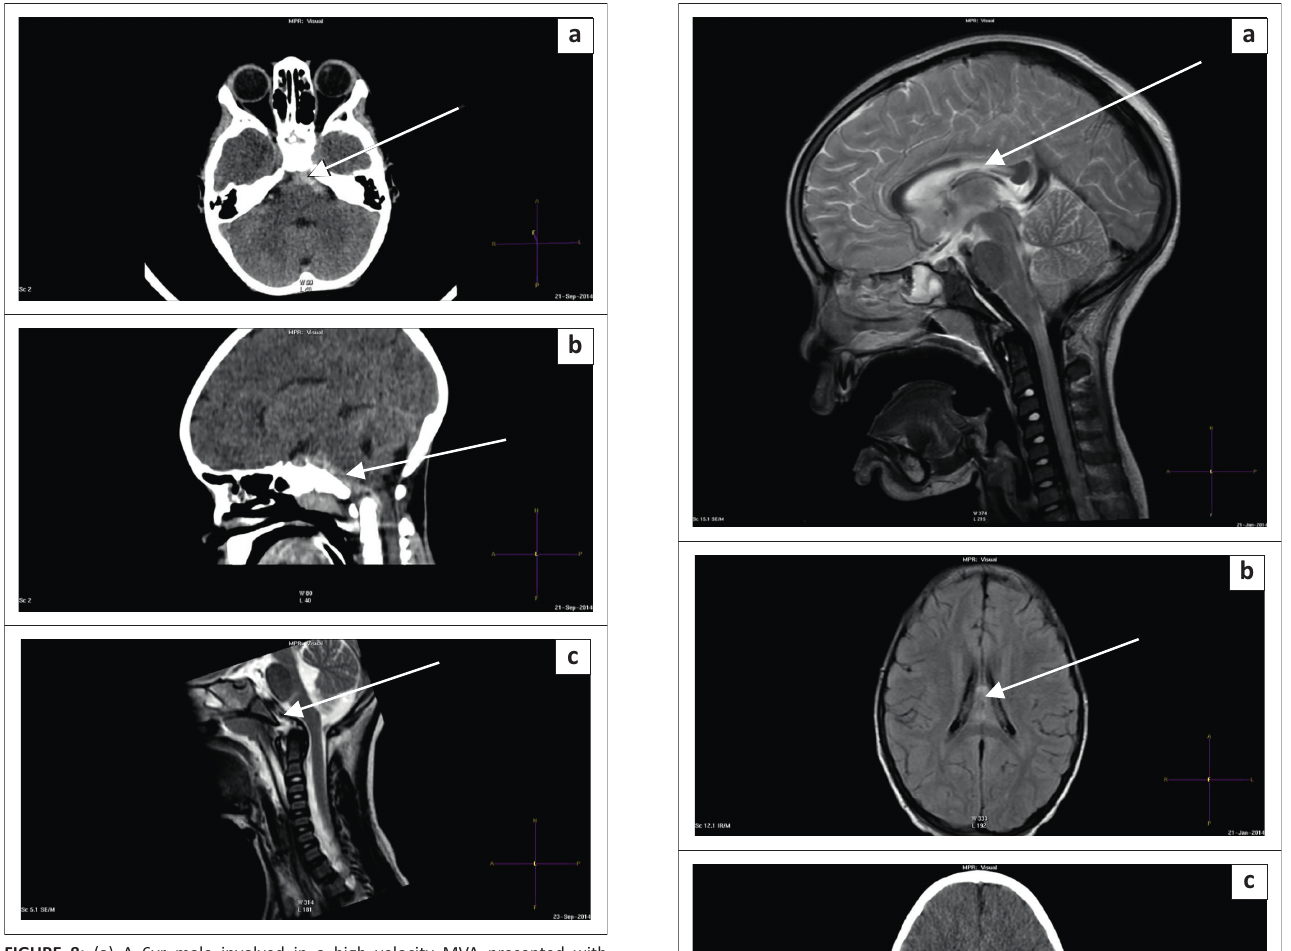
FIGURE 8: (a) A 6yr male involved in a high velocity MVA presented with decreased level of consciousness, hypertonia, decorticate posturing, and severe respiratory distress requiring intubation. Axial CT brain demonstrated a retroclival haematoma (white arrow); (b) Sagittal MPR CT brain confirms the retroclival location of the haematoma and extent (white arrow); (c) Sagittal T2 MRI brain confirmed a retroclival haematoma with tectorial ligament and probable apical ligament disruption (white arrow), with a normal proximal cord.